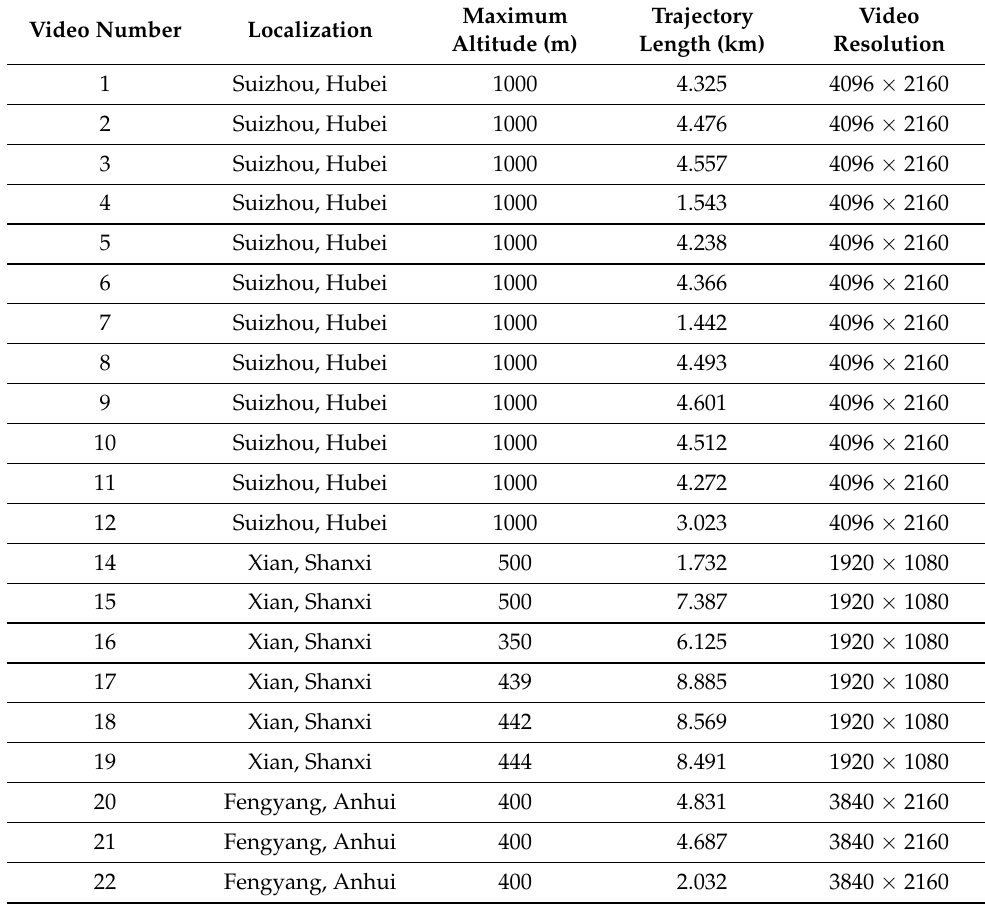
Table 1. Details of the real flight aerial image data set.